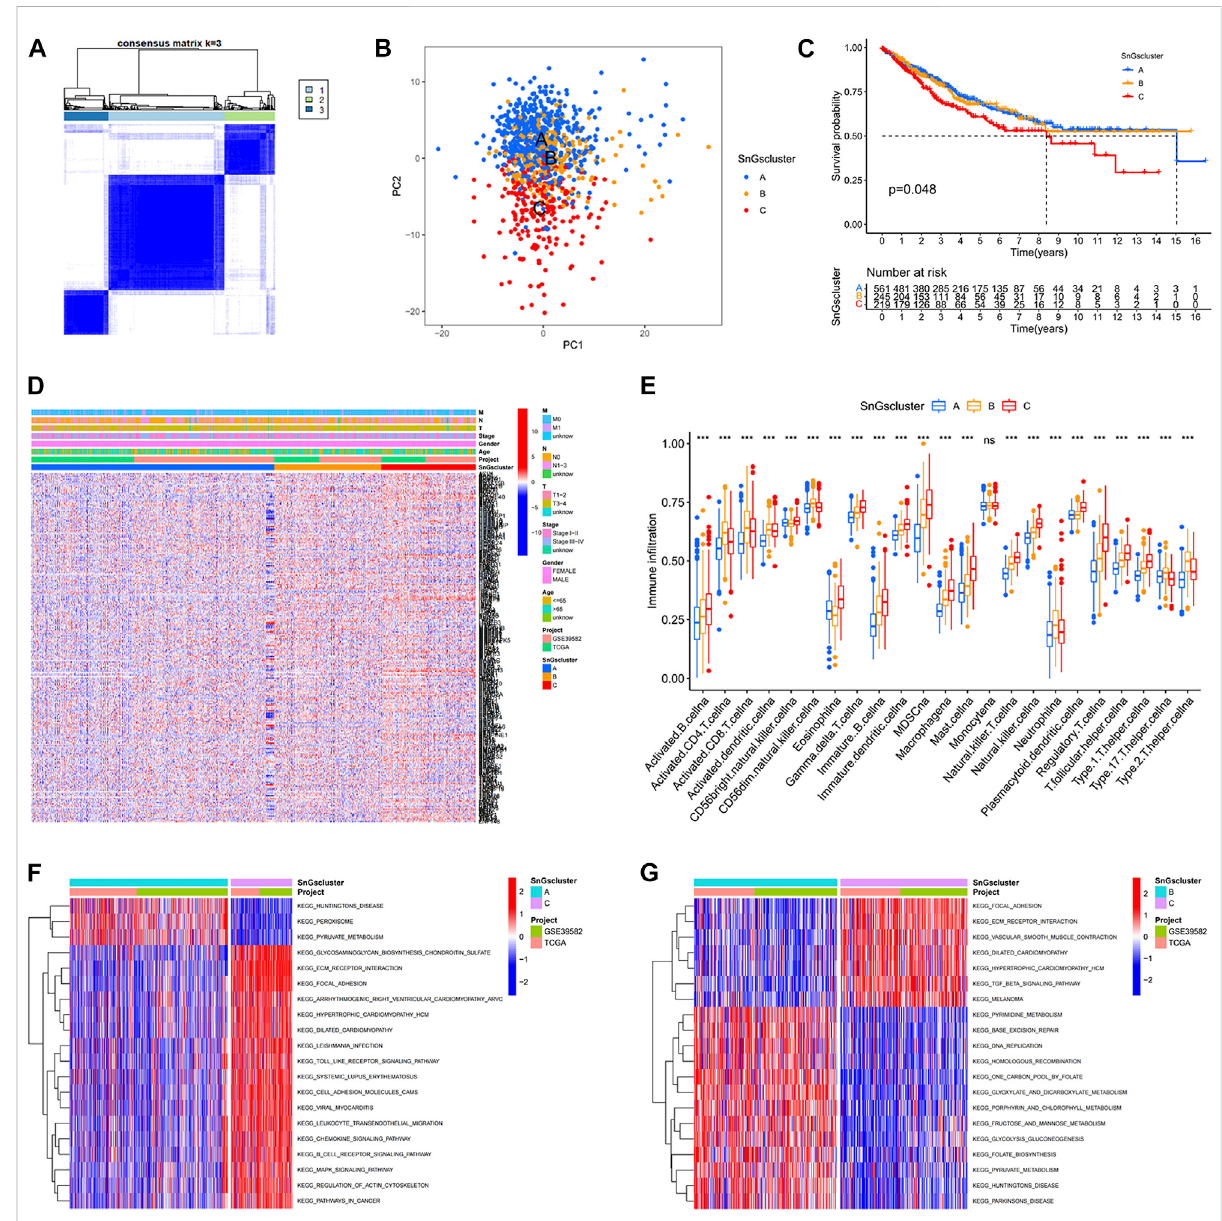
FIGURE 1 Three clusters based on cellular senescence-related gene expression levels. (A) Consensus Cluster Analysis. When cluster Num = 3, the relationshipintheclusterwastightandthecorrelationbetweenclusterswasweak. (B) PCAplot.BluedotsrepresentpatientsinClusterA;yellowdots represent patients in Cluster B; red dots represent patients in Cluster C. (C) Kaplan-Meier survival curves. The prognosis of patients was different among the three clusters, p = 0.048. (D) Heat map. Cellular senescence-related genes were upregulated in Cluster C. (E) Box plots. The horizontalcoordinaterepresentsimmunein fi ltratingcells;theverticalcoordinaterepresentsimmunescores;nsrepresentsnodifferenceinimmune cell scores among the three clusters; ppp p < 0.001. (F) Differential GSVA enrichment pathways between Cluster A and Cluster C. Red represents the highexpressionpathwayandbluerepresentsthelowexpressionpathway. (G) DifferentialGSVAenrichmentpathwaysbetweenClusterBandCluster C. Red represents the high expression pathway and blue represents the low expression